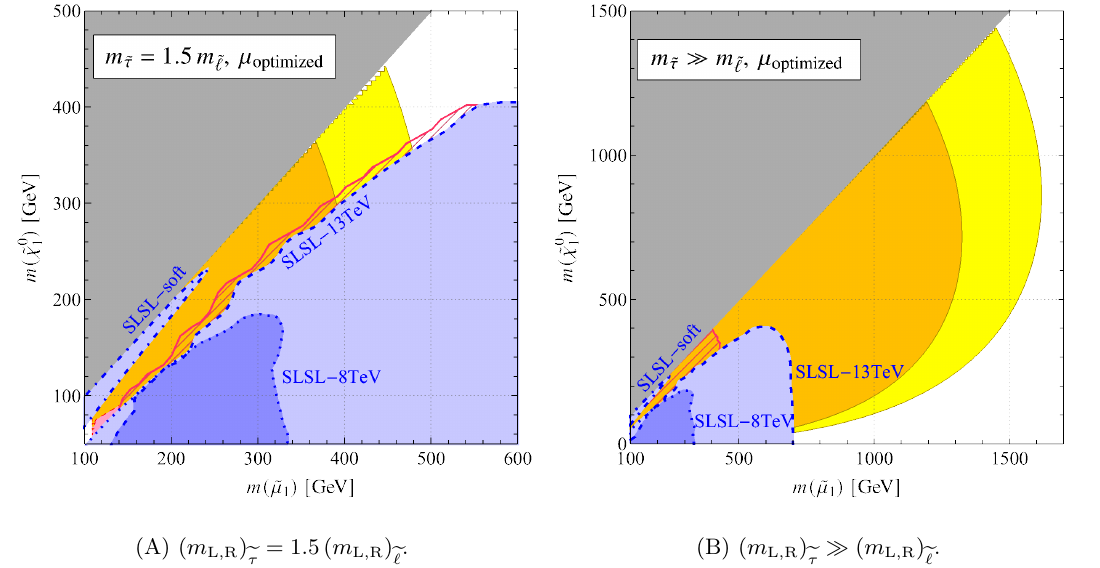
Figure 4. Same as figure 2, but the stau soft masses are larger than those of selectrons and smuons ( e ‘ = e, µ ). Here, m L = m R and tan β = 10 . The µ parameter is optimized ( µ optimized ) at each e e point to explain the muon g − 2 discrepancy at the 1 σ ( 2 σ ) level in the orange-filled (yellow-filled) region. The red-hatched region is potentially excluded by the SLSL search for the decay of the heavier smuon to the lightest neutralino (see the